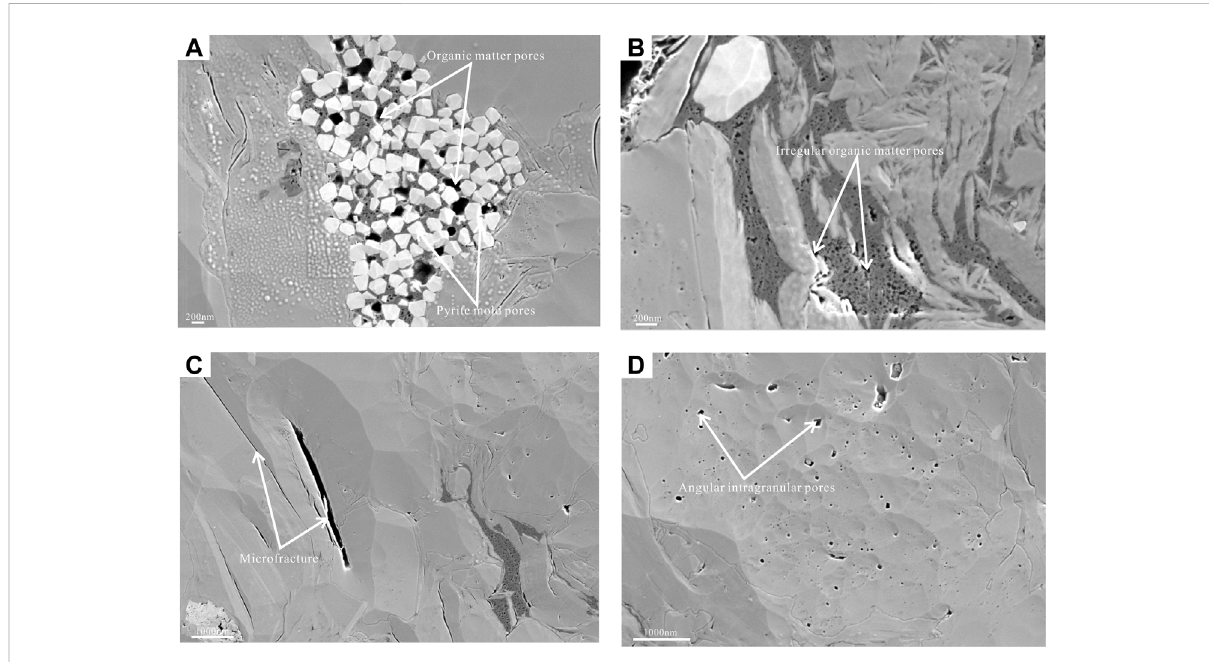
FIGURE 2 FE-SEM images of a shale from the Longmaxi Formation (TOC =0.58%, sample 2) [ (A) mould pores and organic pores between pyrite particles; (B) irregular organic pores; (C) microcracks with different openings; (D) angular granular endopore].